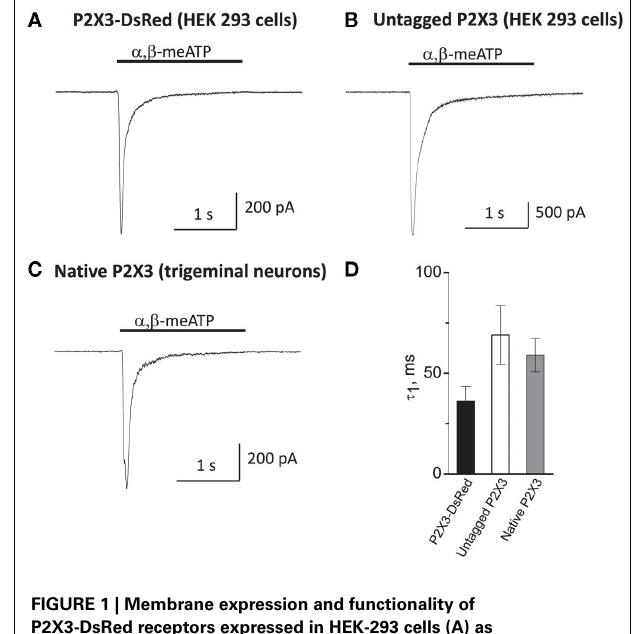
FIGURE 1 | Membrane expression and functionality of P2X3-DsRed receptors expressed in HEK-293 cells (A) as compared to untagged P2X3 receptors expressed in HEK-293 cells (B) and native P2X3 receptors endogenously expressed by cultured mouse trigeminal neurons (C). Kinetics of the characteristically rapid desensitization during agonist application (D) were not significantly different between P2X3-DsRed ( n = 5), untagged P2X3 ( n = 6) and native P2X3 receptors ( n =